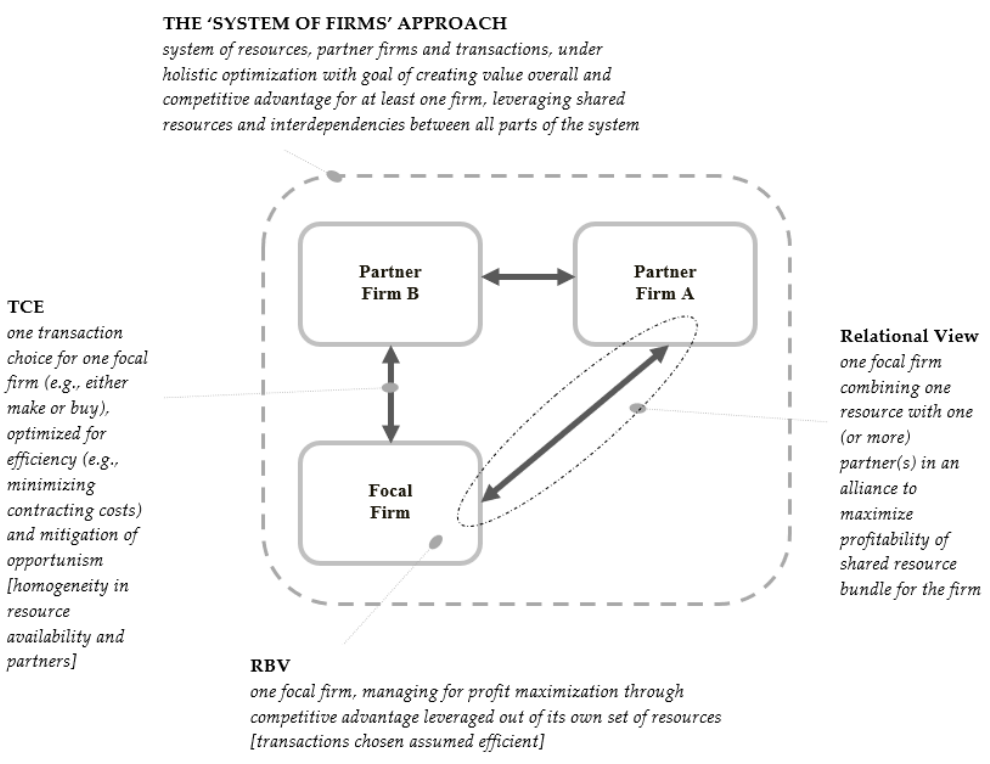
Figure 1. Domains of the relevant concepts and theories.